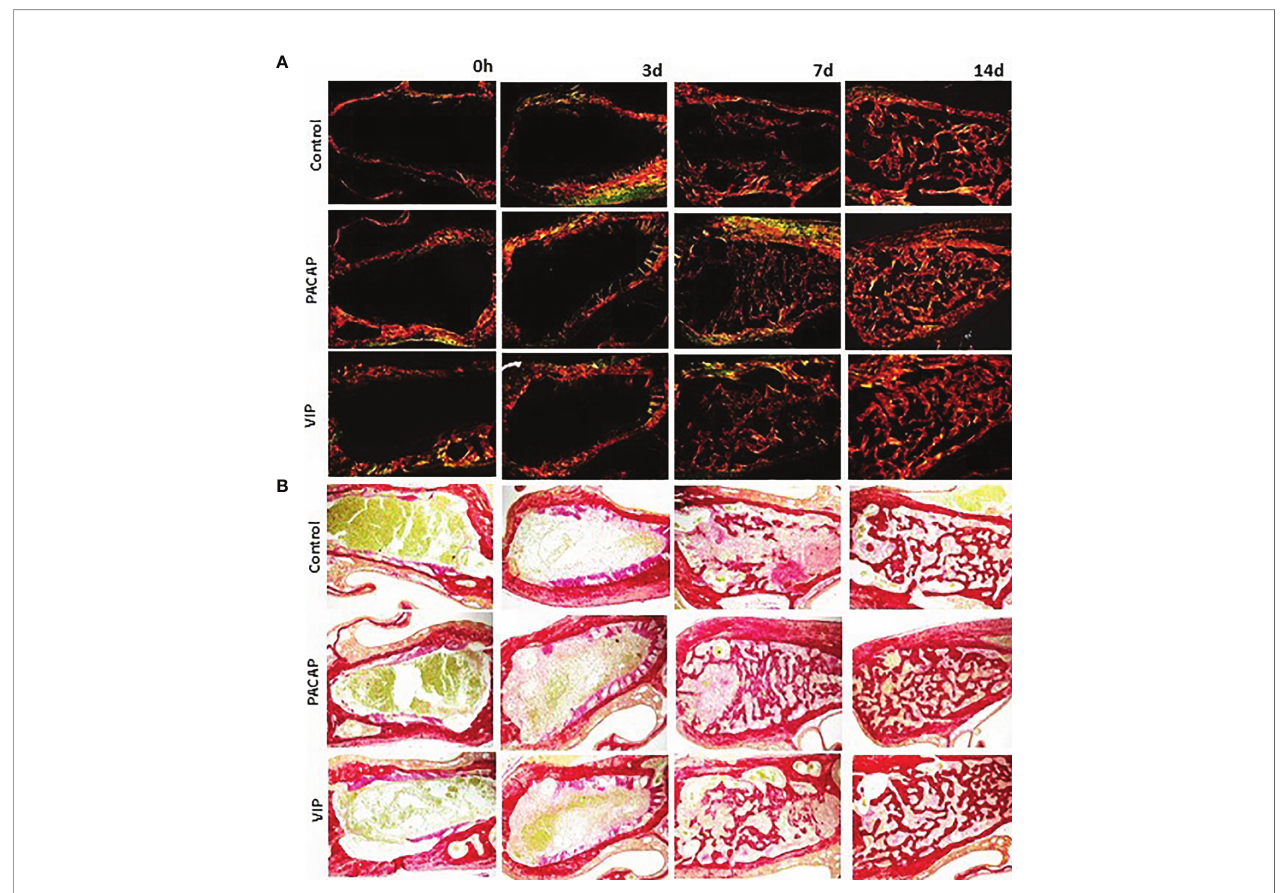
FIGURE 10 | Analysis of birefringence of the collagen fi bers present in the dental alveolus in the 0, 3-, 7-, and 14-day post-extraction periods, in the control, PACAP, and VIP groups. Photomicrographs representing the middle region of the dental alveolus, captured under polarized (A) and non-polarized light (B) , showing the deposition of collagen fi bers with birefringence in green, yellow, and red at 0, 3, 7 and 14 days in all the groups (control, PACAP, and VIP). Stain Picrosirius Red; 10×